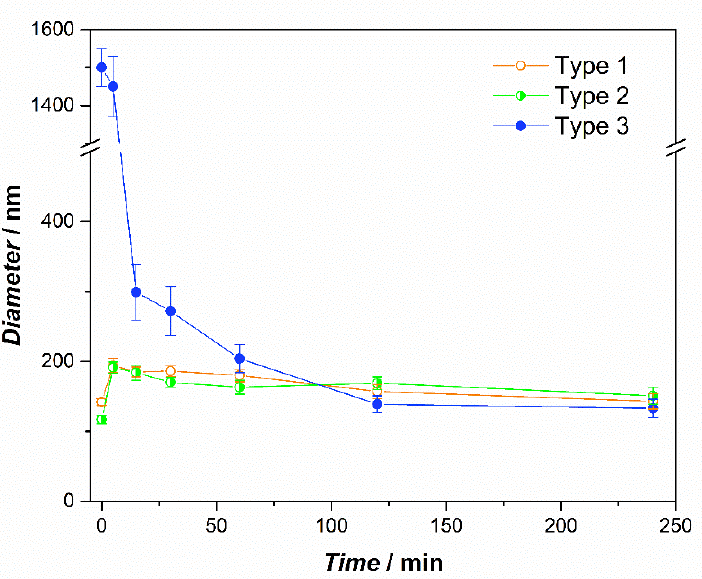
Figure 5. Mean diameter of Type 1–3 liposomes as a function of simulated intestinal digestion time. The error bars represent the standard deviations of the experiments ( n = 3).